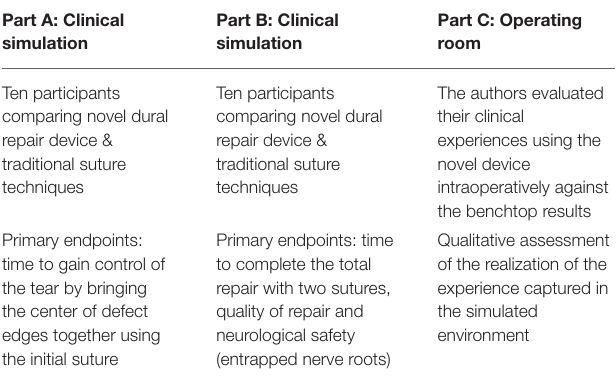
TABLE 1 | Three stages of investigational research for the novel dural repair device. Part A: Clinical